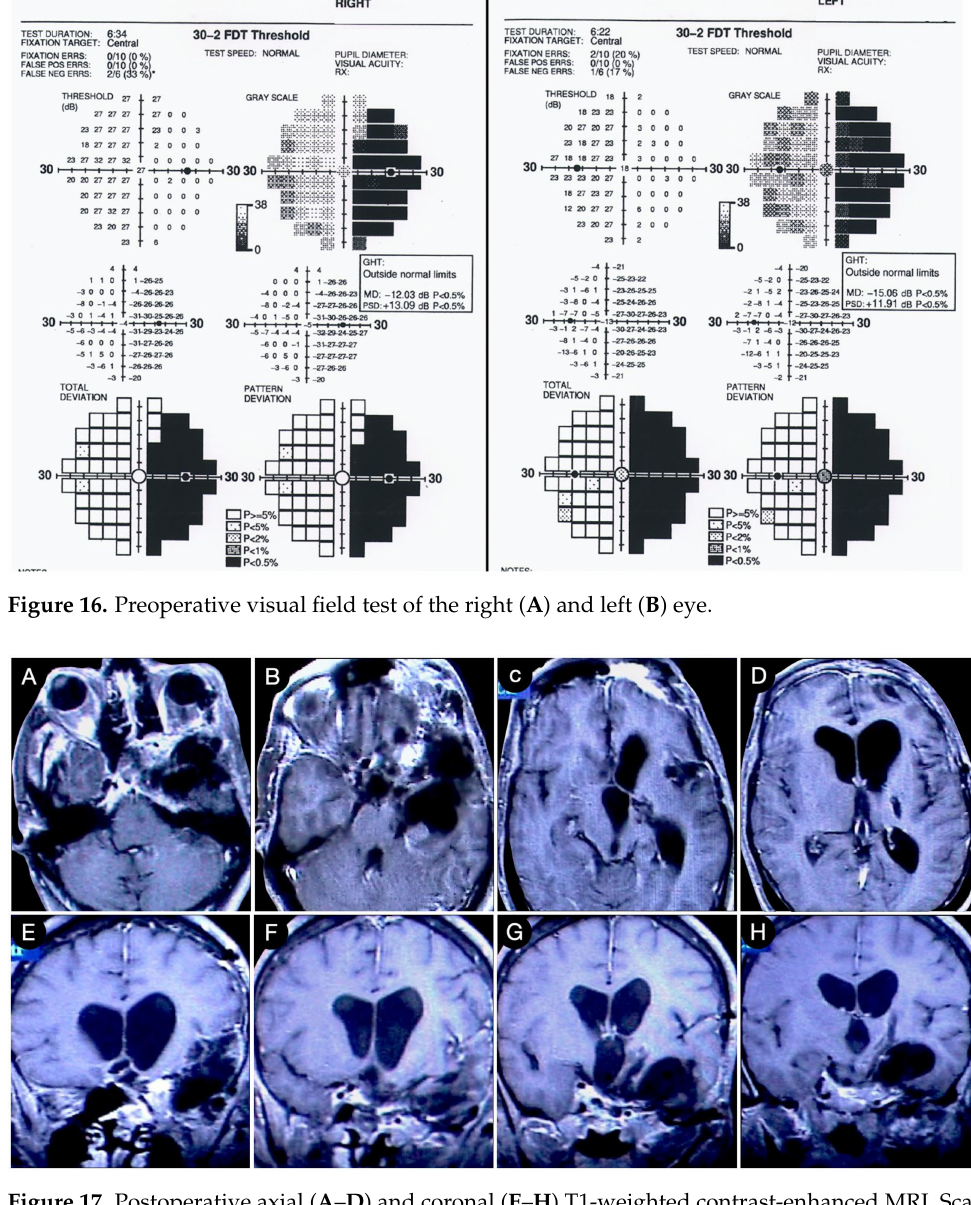
Figure 17. Postoperative axial ( A – D ) and coronal ( E – H ) T1-weighted contrast-enhanced MRI. Scale bar: 5 cm.